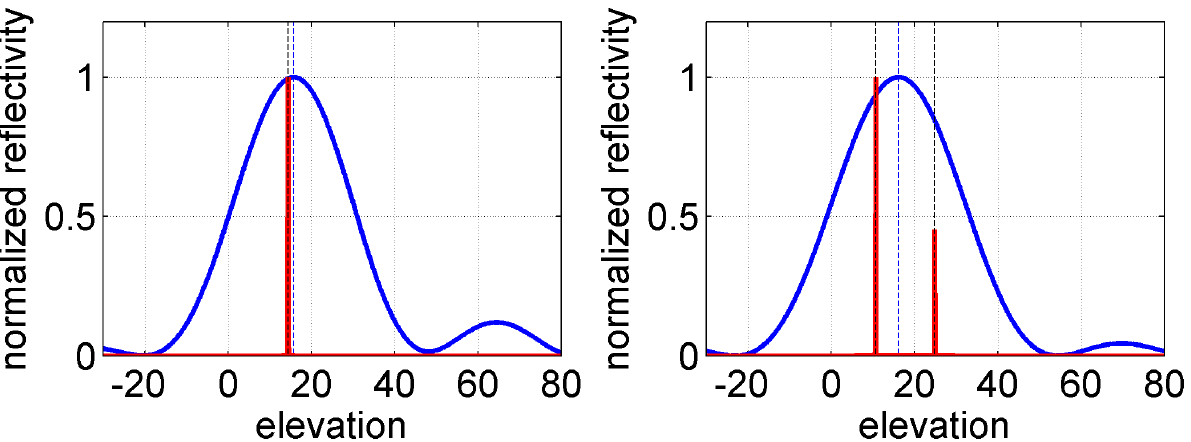
Figure 6. Comparison of the reflectivity profiles along elevation direction reconstructed by MAP (blue) and SL1MMER (red) using the data stack of TSX (left) and TDX cases (right). The true elevation s of the two scatterers are 10 and 25 meter, respectively, an i.e. elevation distance is 0.4 times of the Rayleigh resolution limit.